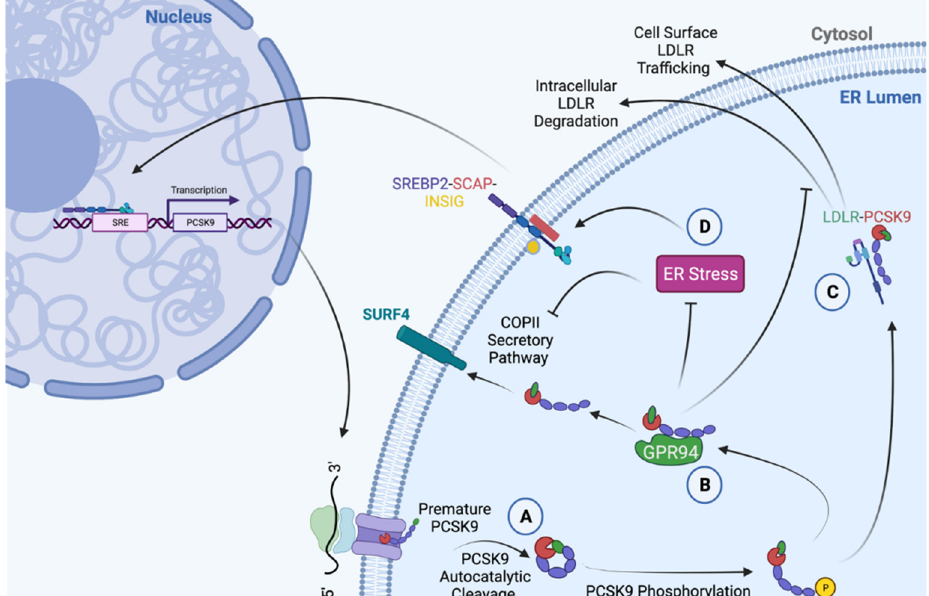
Figure 2. Summary of PCSK9 functions in the ER. ( A ) Mature PCSK9 is formed as a result of an autocatalytic cleavage event at position Q152 ↓ , followed by the binding of the prodomain to the catalytic domain [2]. ( B ) The interaction between PCSK9 and ER chaperone, GRP94, mitigates PCSK9-mediated LDLR degradation [62] , and increases the protein abundance of GRP94 [43,64] . ( C ) In addition to demonstrating co-chaperone functionality by increasing the abundance of GRP94 and protecting against ER stress, PCSK9 can act as a chaperone for pre-mature ER-resident LDLR and promote its trafficking to the cell surface [65] . ( D ) During conditions of ER stress, the abundance of ER-resident PCSK9 increases due to a reduction in secretion, as well as an increase in SREBP2-induced de novo synthesis [63] . Created with BioRender.com.